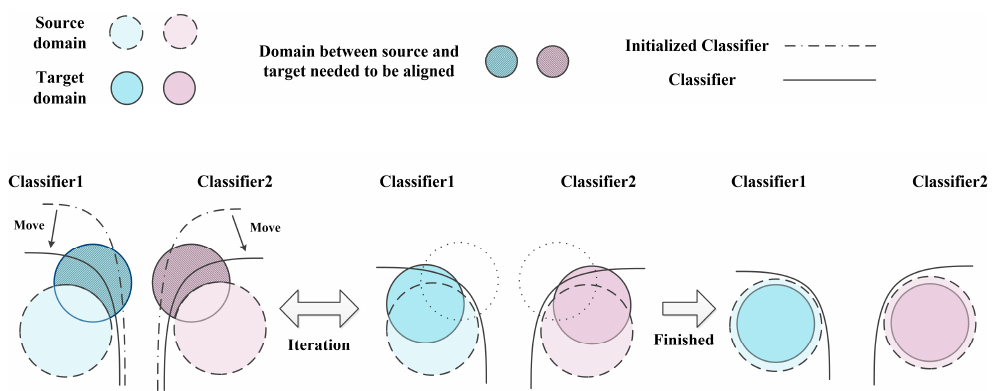
Figure 3. Principle of the adversarial manner of ECB-FAM.